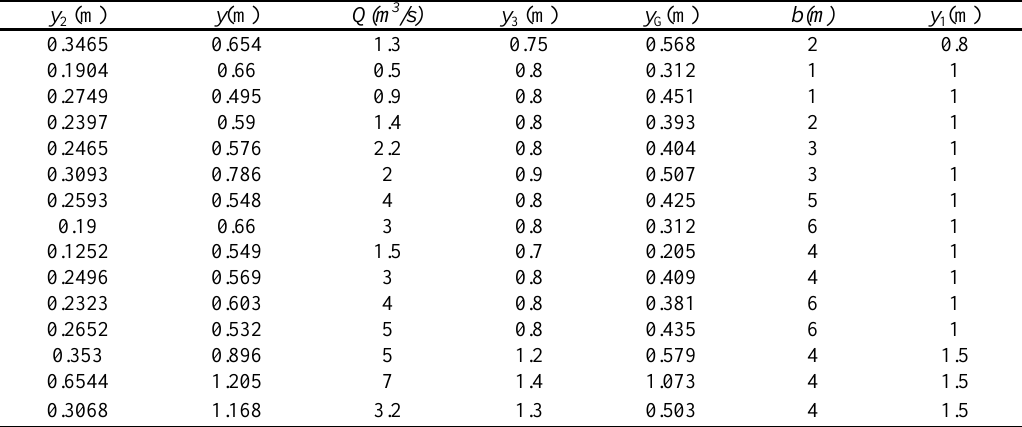
Table 1. Some of the results obtained by the traditional method for submerged